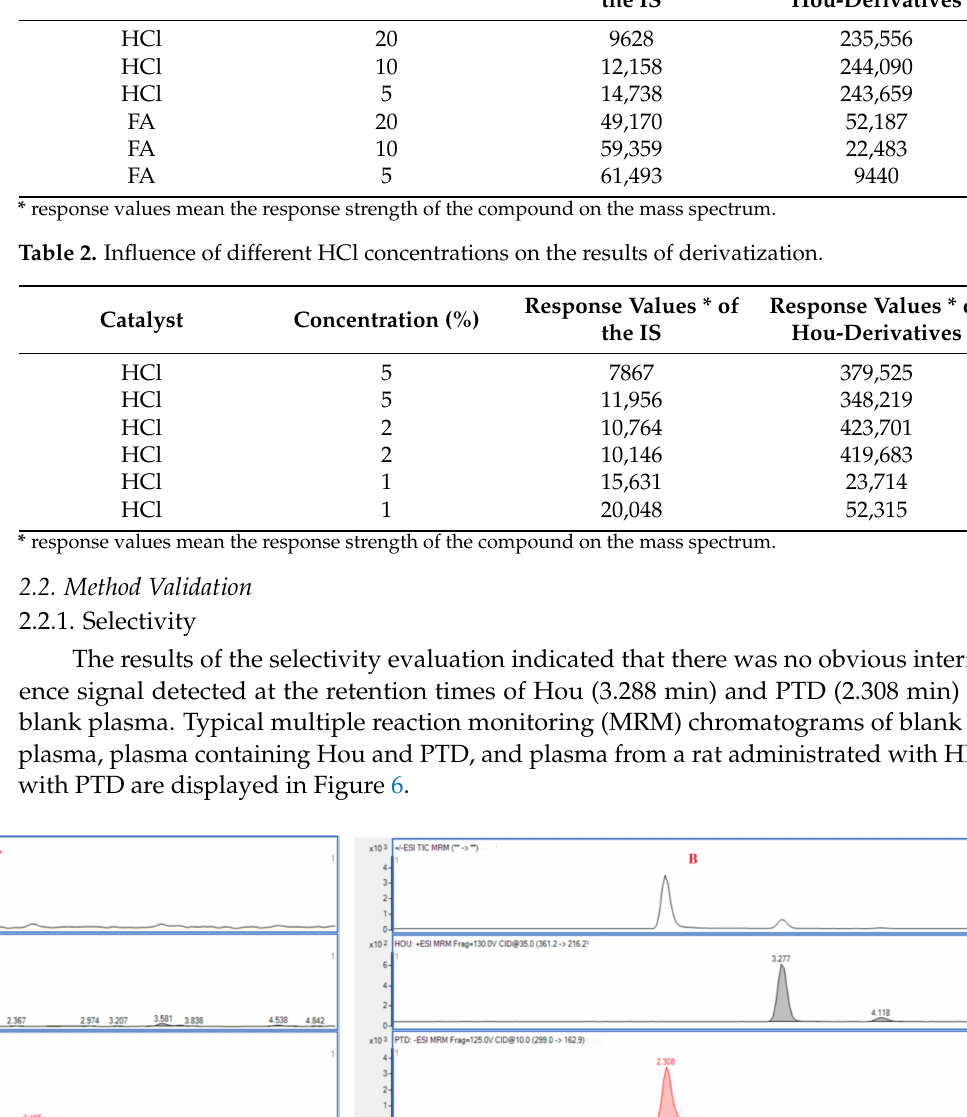
Response Values * of the IS Hou-Derivatives